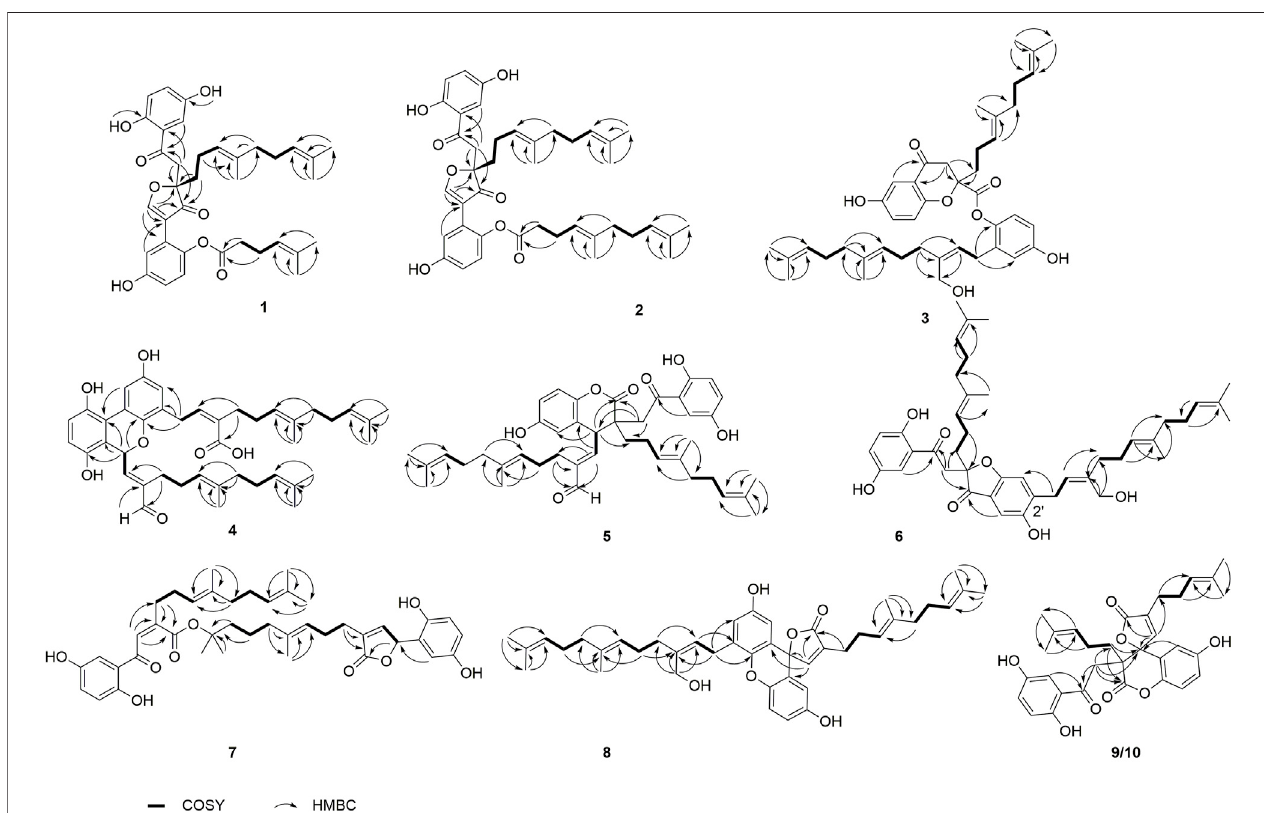
FIGURE 2 | Key COSY and HMBC correlations of 1 – 10